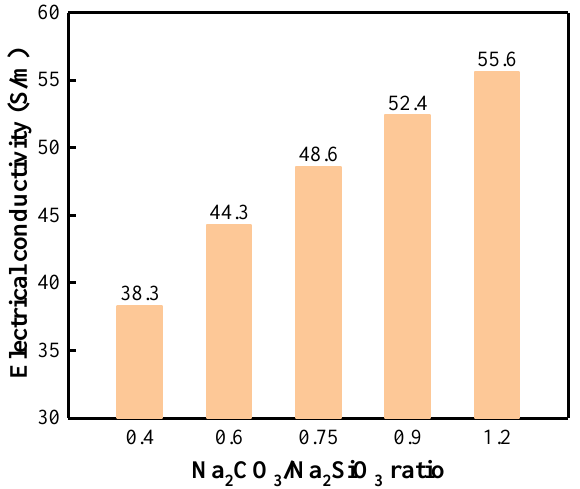
Figure 8. EC of BFA-based AAM pastes with different C/S ratios.